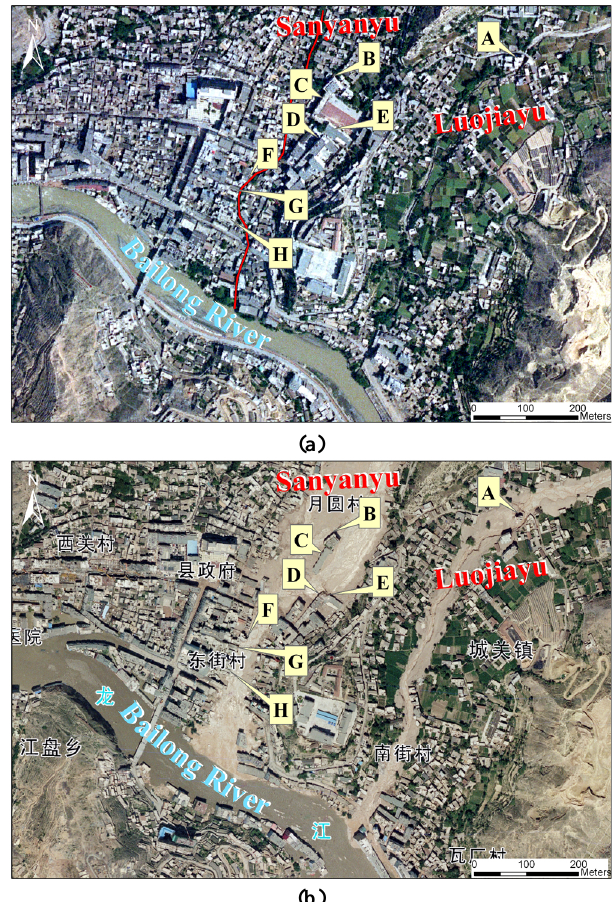
Fig. 2. Damage to buildings in Zhouqu city by the debris flows on 7 August 2010. (a) ALOS satellite image on 10 March 2010. (b) Aerial photo on 10 August 2010 published by the National Ad- ministration of Surveying, Mapping and Geoinformation. The red solid line in (a) indicates the drainage channel before the event. The labels A–H indicate the locations of the eight buildings presented in this case study. Note that a large deviation is seen between the lo- cation of Building E in (a) and (b) because the building was moved downstream by debris